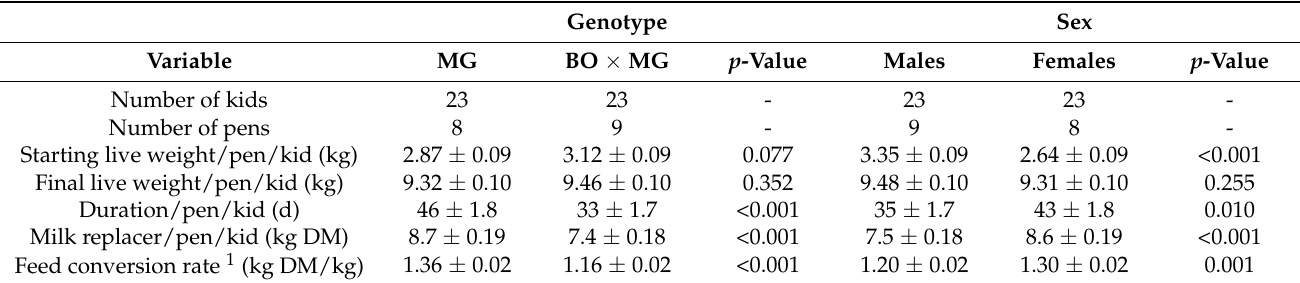
Table 9. Least Square Means ( ± SE) of initial and final live weights and consumption and feed conversion rate for milk replacer of kids according to the genotype (crossbred and purebred) and sex. Crossbred kids were from Boer bucks × Murciano-Granadina goats (BO × MG). Purebred kids were Murciano-Granadina breed